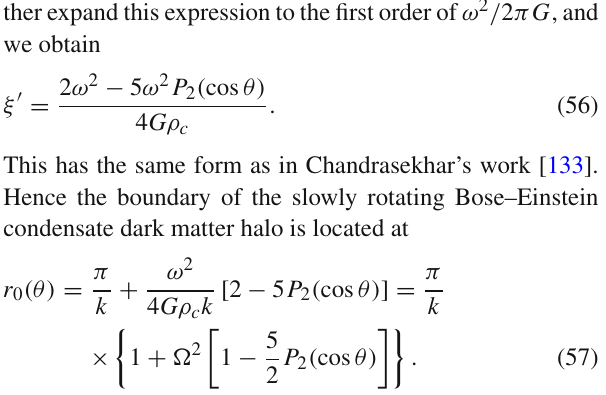
Fig. 1 Variation of the dimensionless ratio ρ(ξ)/ρ c as a function of ξ = kr for a rotating Bose–Einstein condensate dark matter halo for different values of (cid:14) 2 : (cid:14) 2 = 0 (solid curve), (cid:14) 2 = 0 . 01 (dotted curve), (cid:14) 2 = 0 . 0225 (short dashed curve), (cid:14) 2 = 0 . 04 (dashed curve), (cid:14) 2 = 0 . 0625 (long dashed curve), and (cid:14) 2 = 0 . 09 (ultra-long dashed curve),